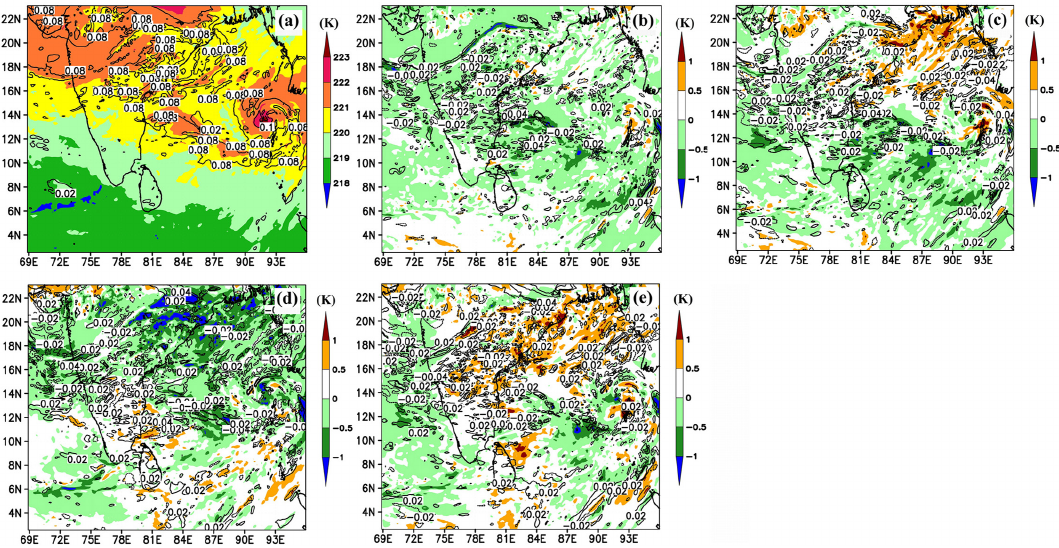
Figure 6. Spatial distribution of (a) initial temperature (shaded) and specific humidity (contours with interval 0.01gkg − 1 ) at 200hPa in CTL and analysis difference (VAR − CTL) in (b) VARAMV, (c) VARPREP, (d) VARRAD and (e) VARPREP + RAD for Phailin at 12:00UTC 9 October